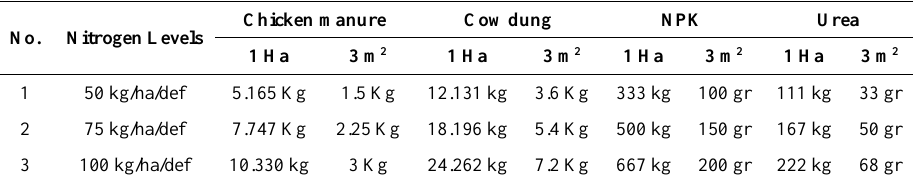
Table 1. Use of Nitrogen Levels in Various Nitrogen